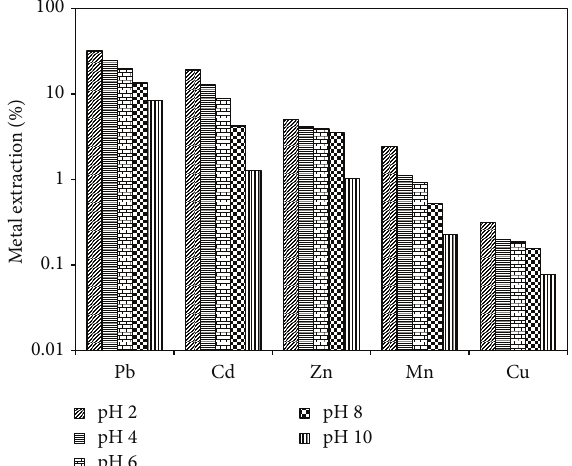
Figure 12: Leachability of metal ions at various pH conditions from NFA.